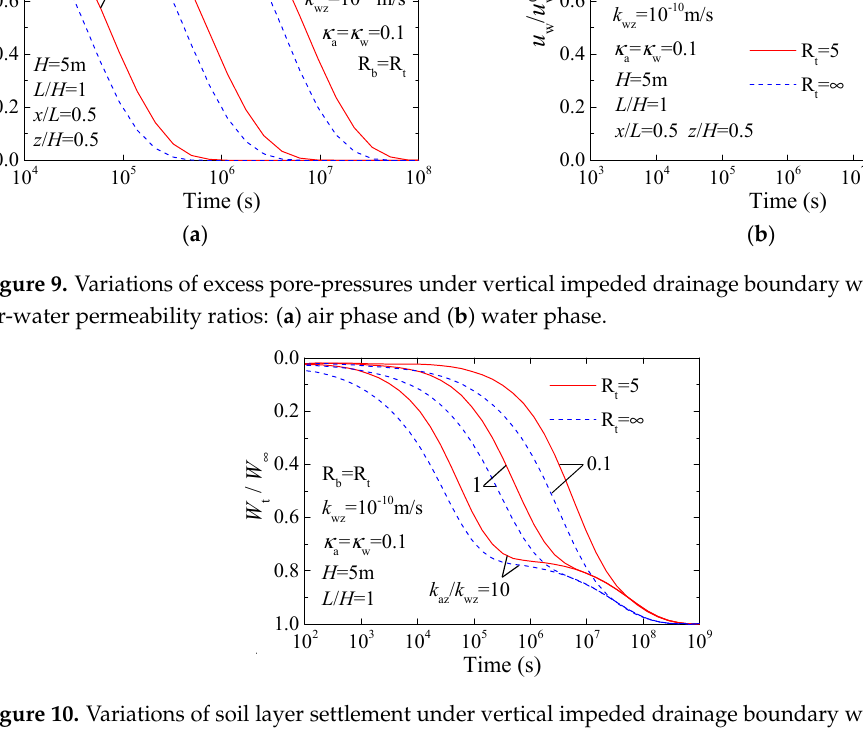
Figure 10. Variations of soil layer settlement under vertical impeded drainage boundary with different air-water permeability ratios.